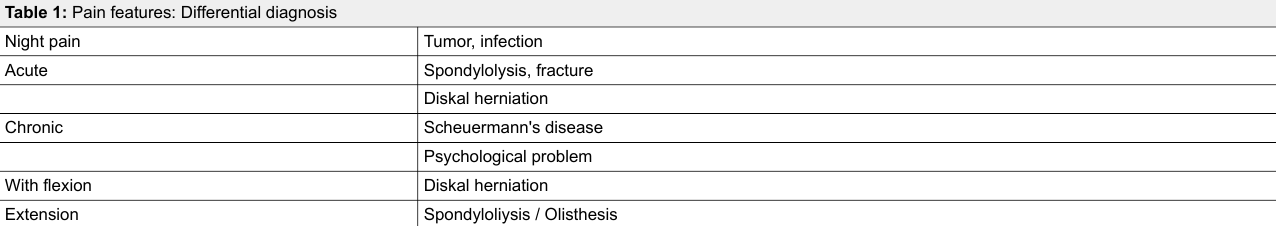
Table 1: Pain features: Differential diagnosis Night pain Tumor,